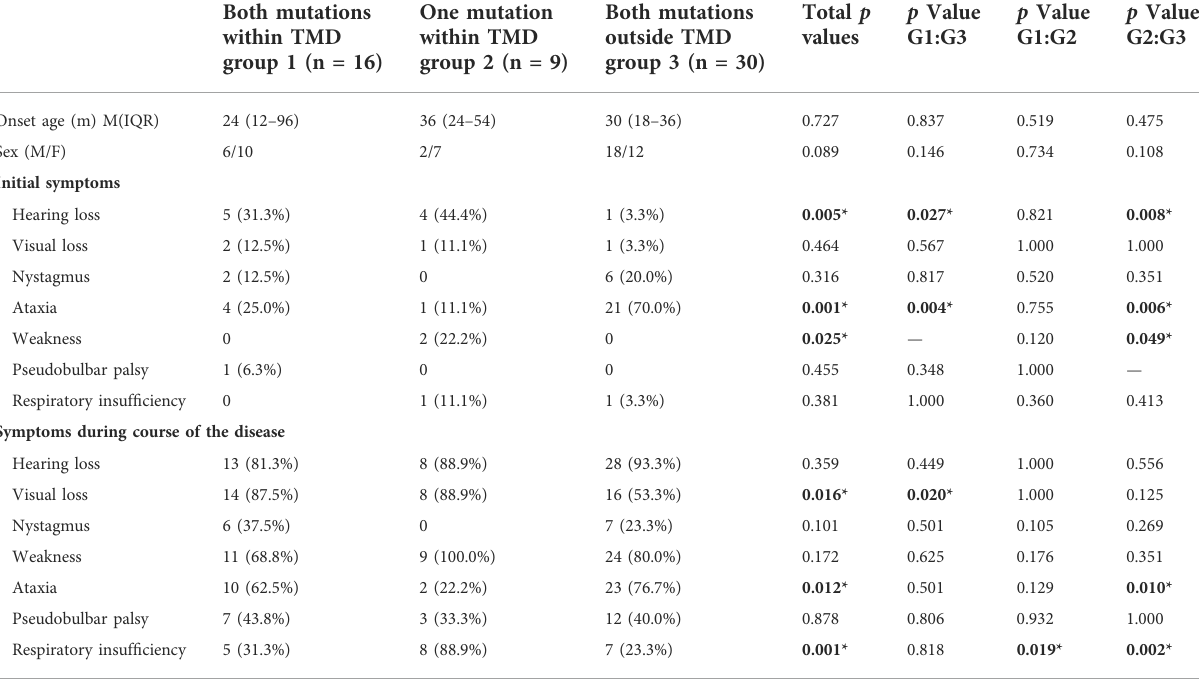
TABLE2Comparisonoftheclinicalcharacteristicsofpatientswithmissensemutations inthedifferenttransmembraneregionsofthe SLC52A2 gene.